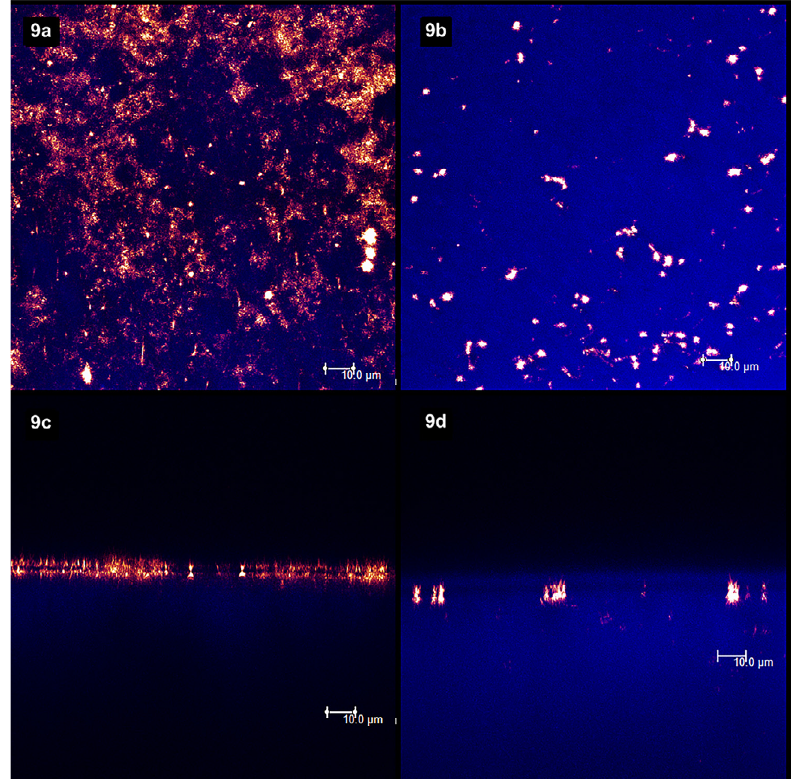
Figure 9- The application of the 22,600 ppm NaF varnish resulted in many solid deposits on the surface (9a) and at the aperture of the tubules (9c), but they were significantly diminished after the erosive challenge, both on the surface (9b) and at the tubules’ apertures